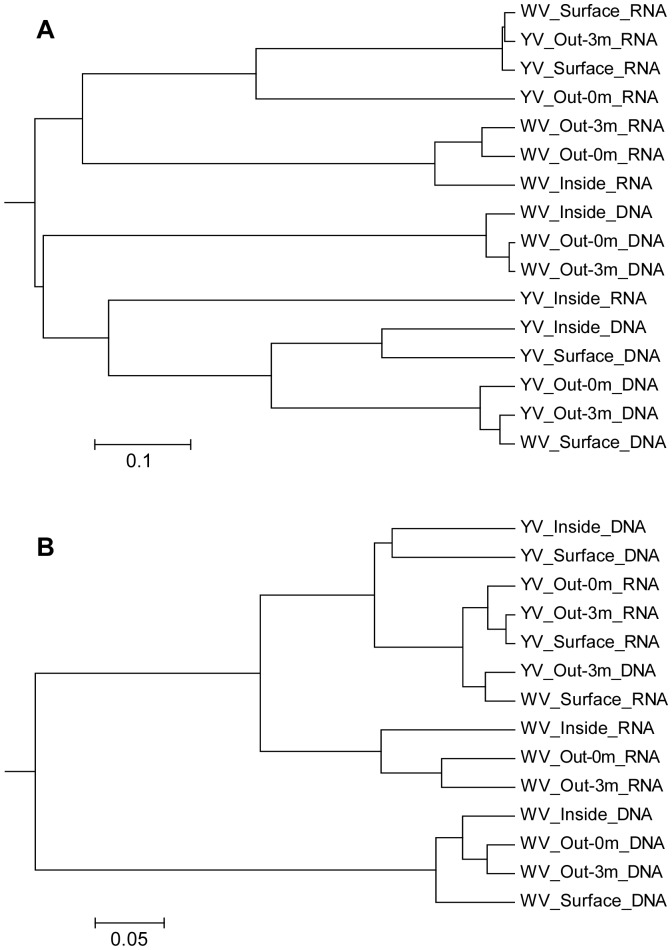
UPGMA trees constructed from Thetayc distances between bacterial libraries (A) and Bray-Curtis distances between archaeal libraries (B).